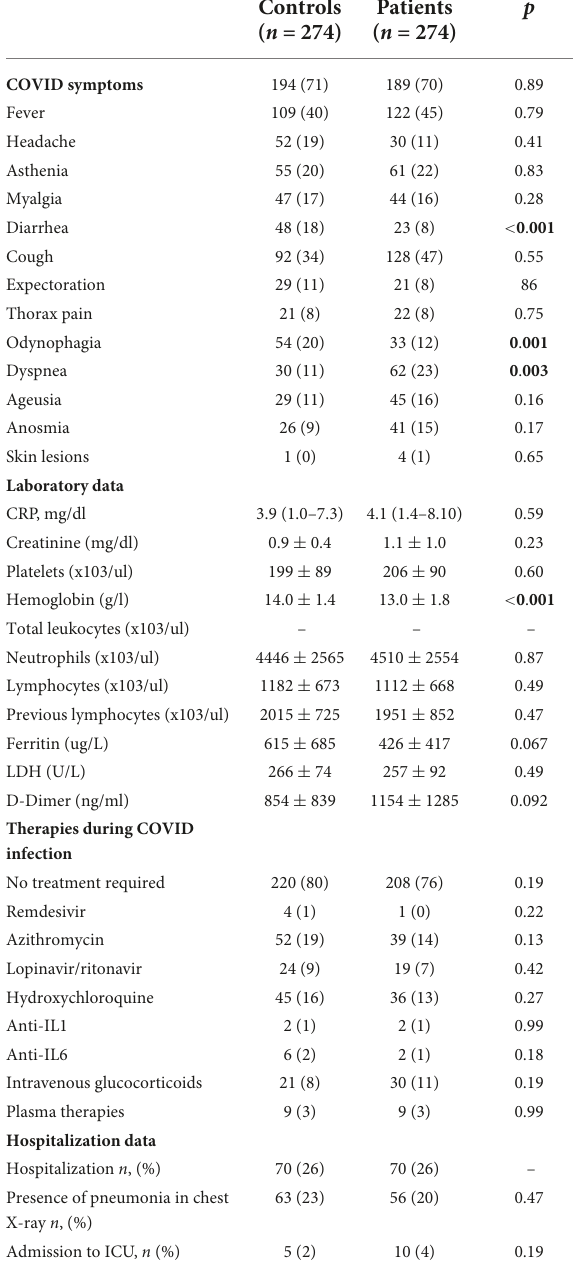
TABLE 3 Main clinical, analytical and therapy of coronavirus (COVID) disease in patients with rheumatic immune-mediated diseases (IMIDs) and case